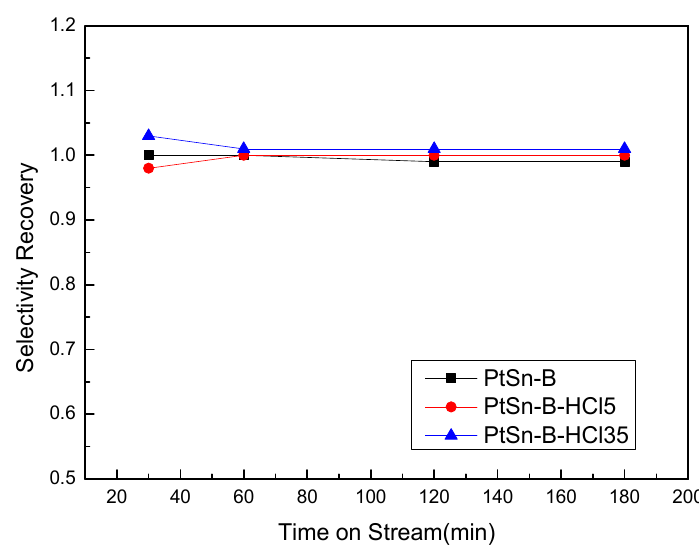
Figure 2. Recovery of propylene selectivity of Pt-Sn / Al 2 O 3 . Reaction conditions—catalyst weight: 0.3 g; reaction temperature: 600 ◦ C; and flow rate: N 2 :H 2 :C 3 H 8 = 70:30:30 (mL / min), WHSV = 11.8 h − 1 .